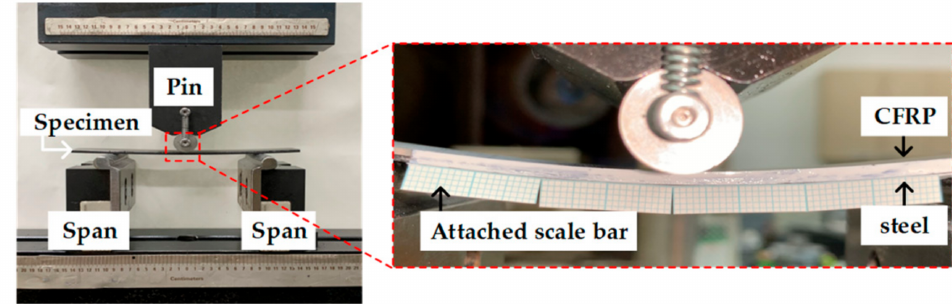
Figure 5. Experimental setup for ENF